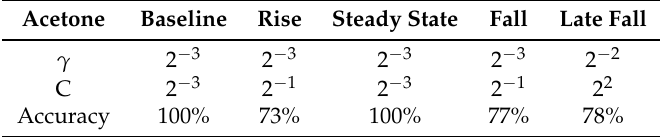
Table 5. Cross validation results for acetone.